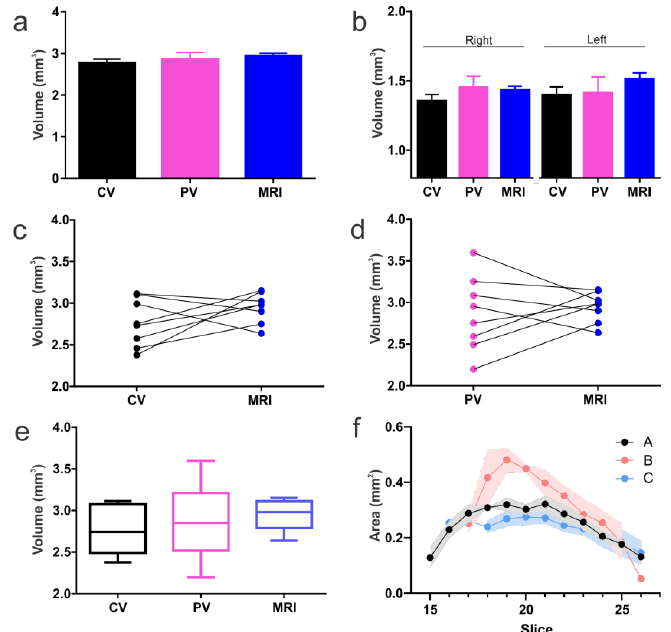
Figure 6. Histological and MRI derived BLA volumes. ( a ) No significant differences were found in BLA volumes extracted from Cresyl violet (CV), parvalbumin (PV) or DTI MRI. ( b ) Similarly, no significant differences were seen in volumes from either the right or left BLA. ( c ) CV anatomical data matched well to MRI. ( d ) PV data exhibited greater variability than CV in BLA volumes but also matched MRI-derived data. ( e ) Box and whisker plots illustrate that BLA volumes from MRI had the lowest variability while PV exhibited the largest. This low variability in the MRI may be due to use of all the data (6 – 9 slices), while histology measurements were at 120 µm intervals. ( f ) Inter-rater assessments yielded excellent concordance between the individual who devised the protocol (Rater A) and an experienced MRI/amygdala research associate (Rater C). After training, an individual (Rater B) with no MRI nor amygdala knowledge was able to reasonably delineate the BLA with a 14.6% over estimation (see Supplementary Figure